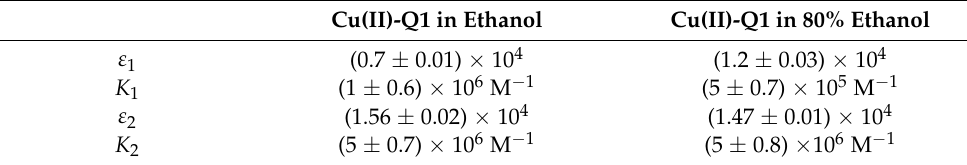
Table 1. Calculated parameters of Q1 chelating complexes in ethanol solution and in water–ethanol